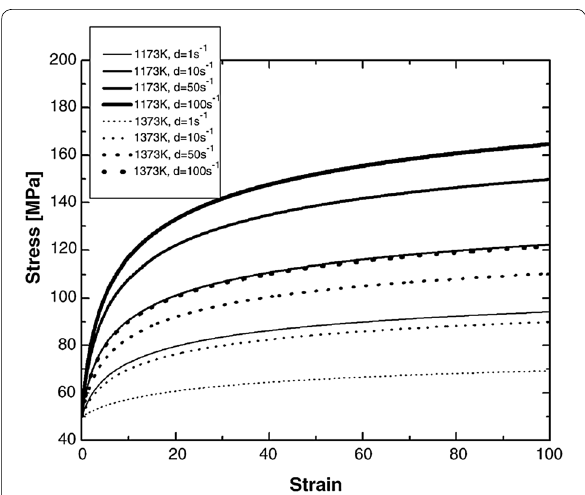
Figure 53 Relationship between the stress and the strain [124]